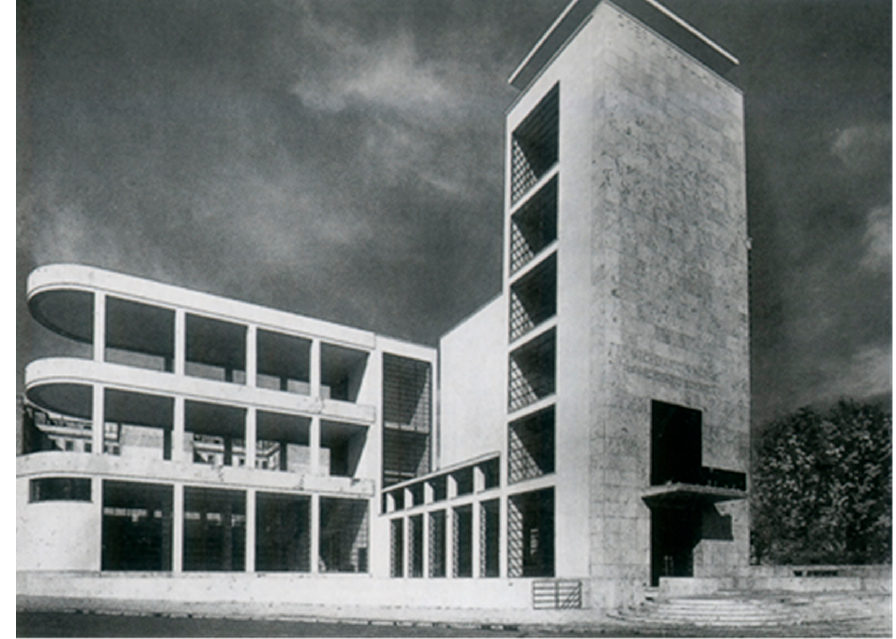
Figure 16. Luigi Moretti. House of G.I.L. Rome (1932–1937). The tower and outdoor gyms. Photo from (Marconi 1941, p. 361).